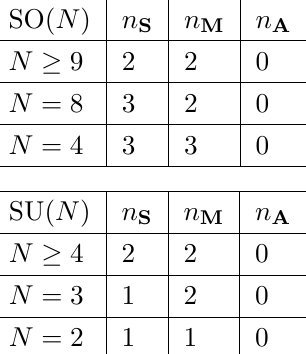
Table 1 . The counting of S 3 representations of quasi-invariant color structures. The results for SO( N ) with N = 7 , 6 , 5 are the same as those for N ≥ 9